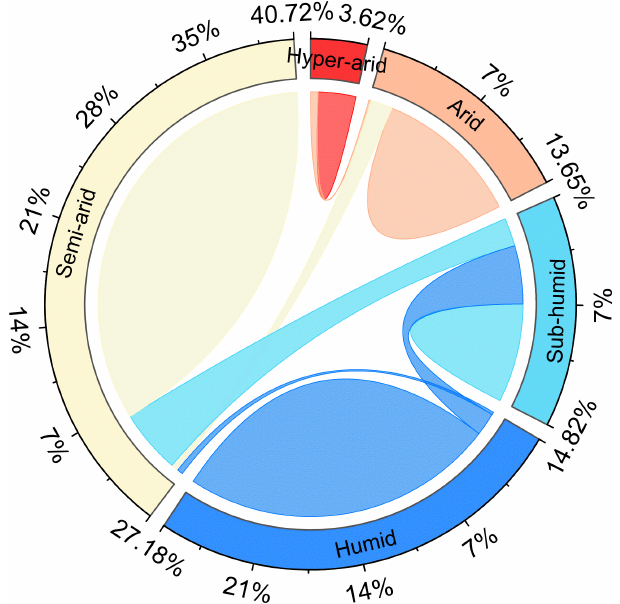
Figure A4. The shift in hydrological regions defined by the multiyear average AI index from the period of 1916–1945 to the period of 1986–2015. The outermost numbers represent the percentage of hydrological regions in 1916–1945.